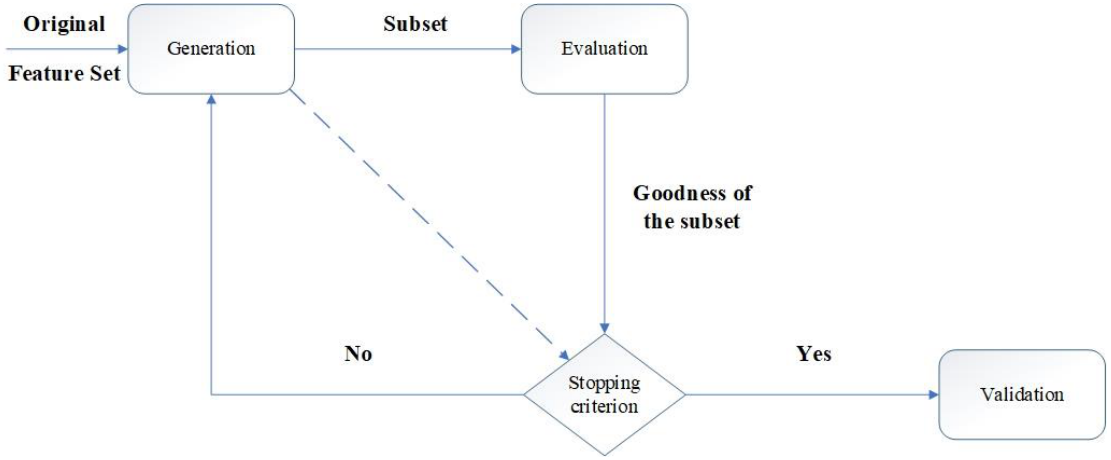
Figure 17. FS method flowchart.